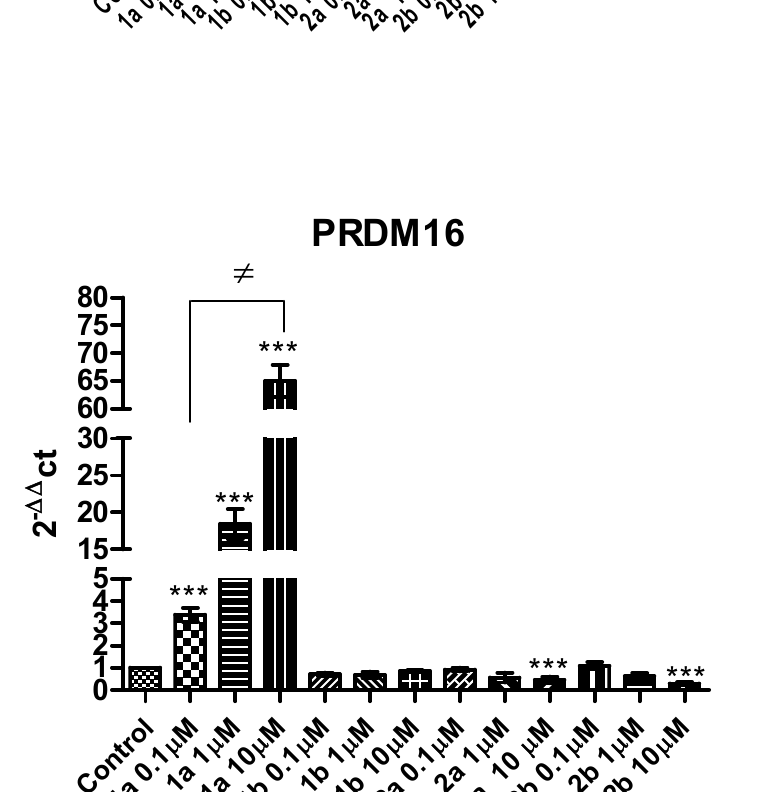
WAT depots, in mice [63]. UCP1 gene up ‐ regulation is also associated with adipogenic